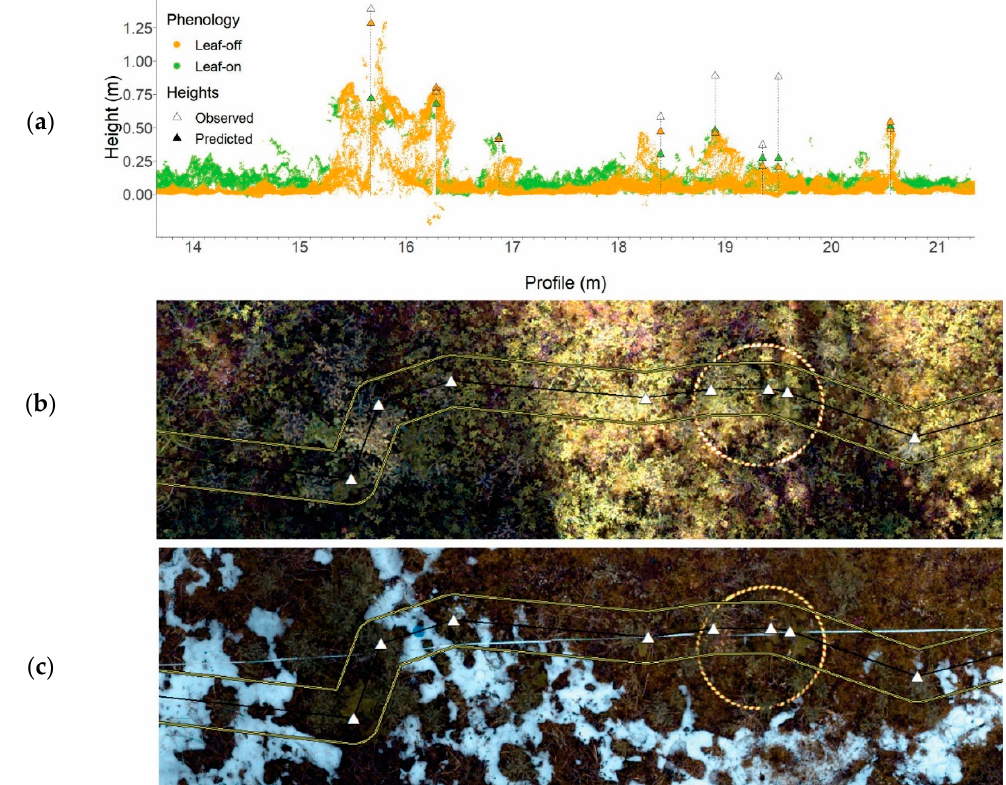
Figure 6. A sample vertical profile from the 0.35 cm ground sampling distance (GSD) drone-based image point clouds (DIPCs) ( a ), and respective leaf-on ( b ) and leaf-off ( c ) orthomosaics. The profile was extracted from a 20 cm wide transect (black line with yellow buffer) connecting several surveyed seedlings (white triangles). The height estimates come from the DIPC TIN method (the weighed mean elevation of the three closest nodes in the DIPC triangular irregular network). The scale of the vertical profile is slightly coarser than that of the displayed images, because the transect is not straight. Ground photos of the 1-m diameter, red and yellow hula-hoop, and a 3D view of the corresponding point clouds from different GSD can be watched in Video S1.